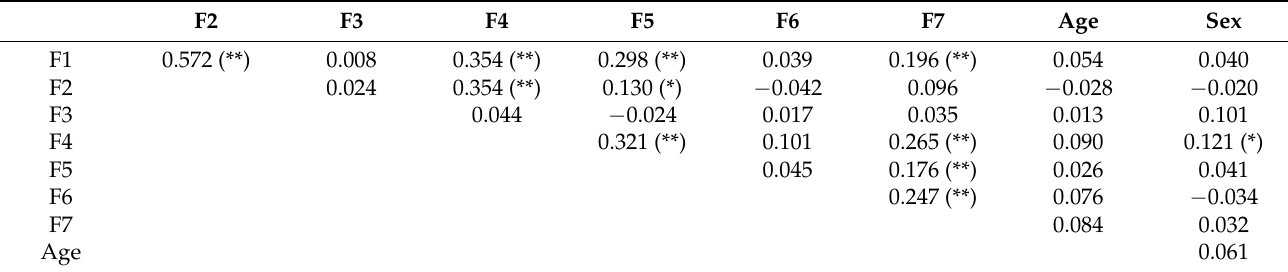
Table 2. Pearson bivariate correlation on 7 factors, age and